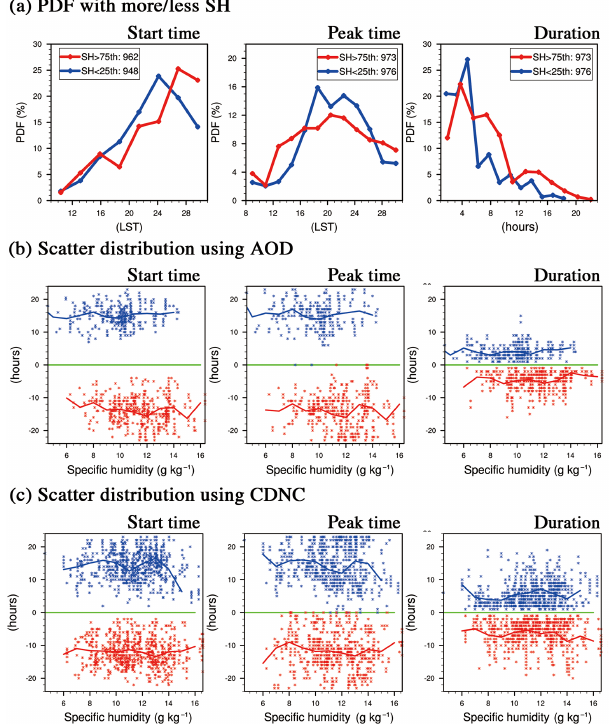
Figure 7. (a) PDFs of start time (units: LST), peak time (units: LST), and duration (units: hours) of heavy rainfall with less mois- ture (blue lines, SH at 850hPa less than the 25th percentile, data form ERA-Interim) and more moisture (red lines, SH at 850hPa more than the 75th percentile, data from ERA-Interim). (b) and (c) are scatter distributions of SH start time/peak time/duration for clean cases (blue points) and polluted cases (red points), respec- tively, using AOD and CDNC. Green lines stand for the start/peak time at 08:00LST or the duration is 0h. Positive (negative) values stand for the hours away from 08:00LST or 0h in clean (polluted) cases. Blue (red) lines stand for the mean values of rainfall charac- teristics at each integer of SH in clean (polluted) cases.